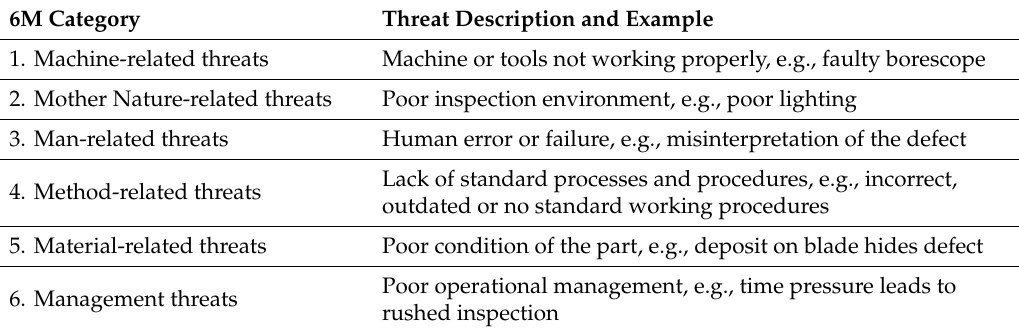
Table 2. The 6M categories for threats with description and